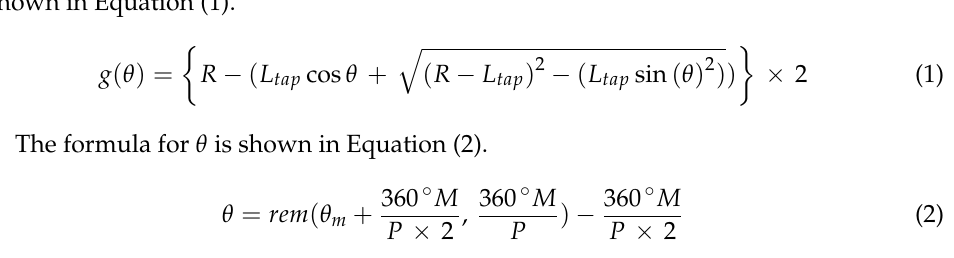
Figure 4. Back emf and cogging torque waveforms of the conventional model; ( a ) no-load back emf; ( b ) cogging torque.